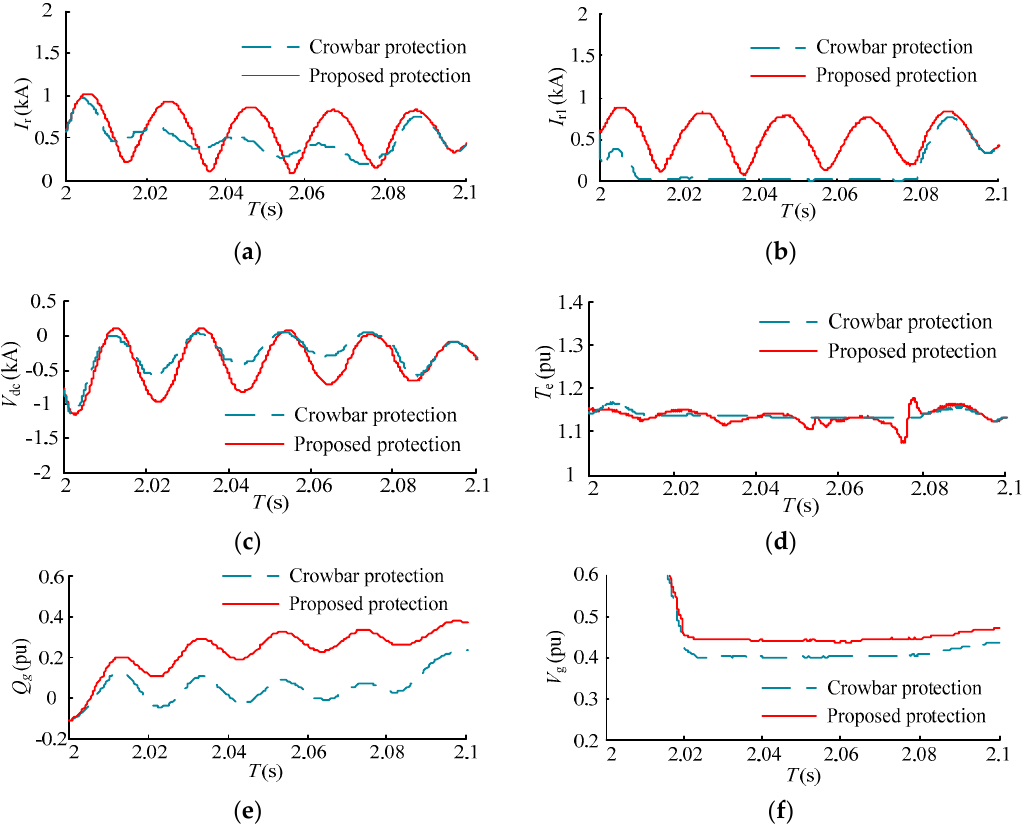
Figure 16. Comparisons between proposed protection and crowbar protection under a voltage sag of 0.6. ( a ) Rotor current; ( b ) RSC current; ( c ) electromagnetic torque; ( d ) DC-link bus voltage; ( e ) reactive power at the grid; and ( f ) the terminal voltage.